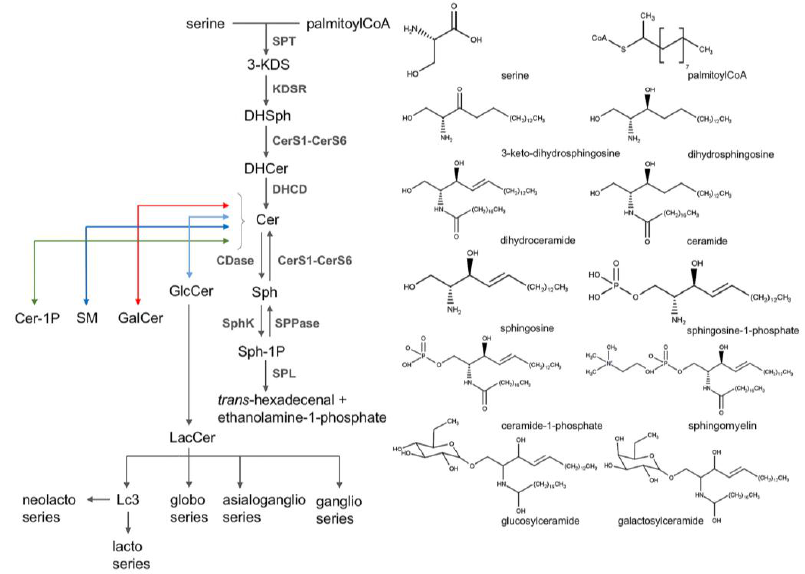
Figure 2. Sphingolipids metabolism and their chemical structures. Lc3: GlcNAcβ1-3Galβ1-4Glcβ-Cer for others see the abbreviation list.